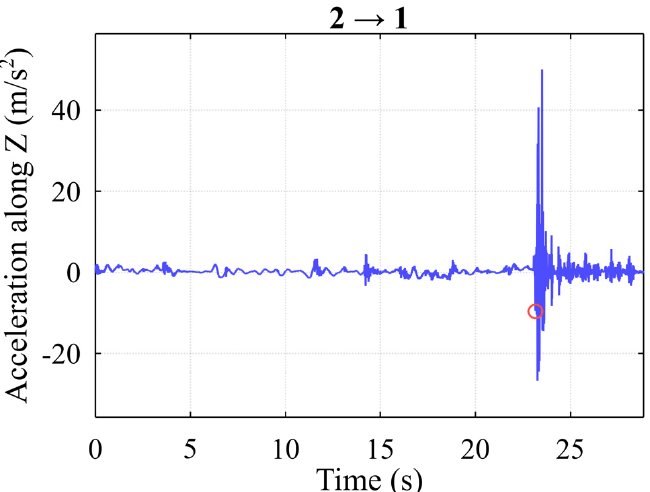
Figure 18. The event at the main signal (here the red circle indicates the starting point of the initial impact).